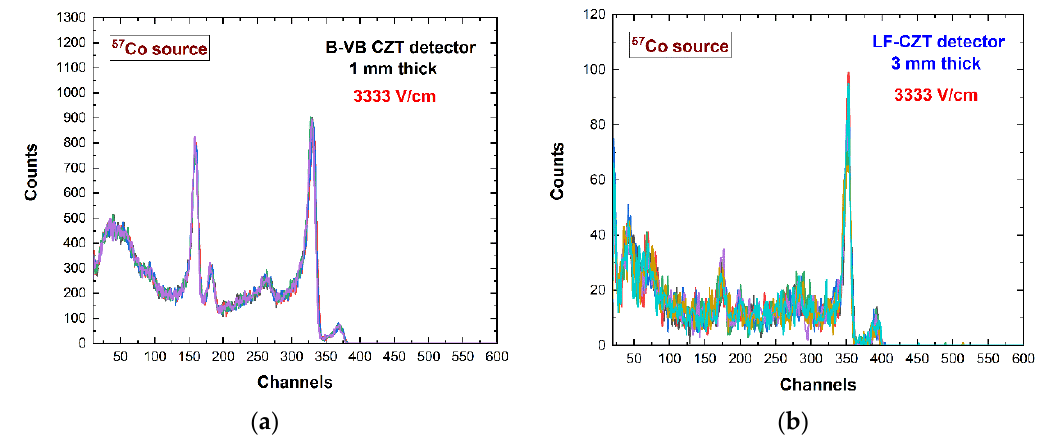
Figure 9. The energy spectra measured with the ( a ) B-VB CZT pixel detector and ( b ) LF-CZT pixel detector within a time window of one hour. For each time window of one hour, we measured six energy spectra with an acquisition time of ten minutes. 57 Co sources with different activity were used. The time stability was